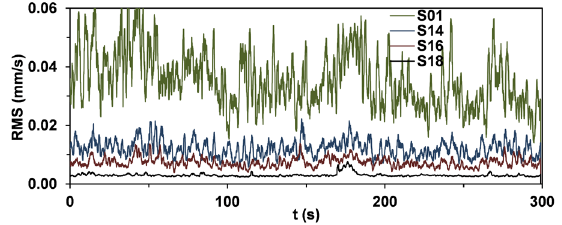
Figure 8. RMSs of recording velocities in configuration C2.